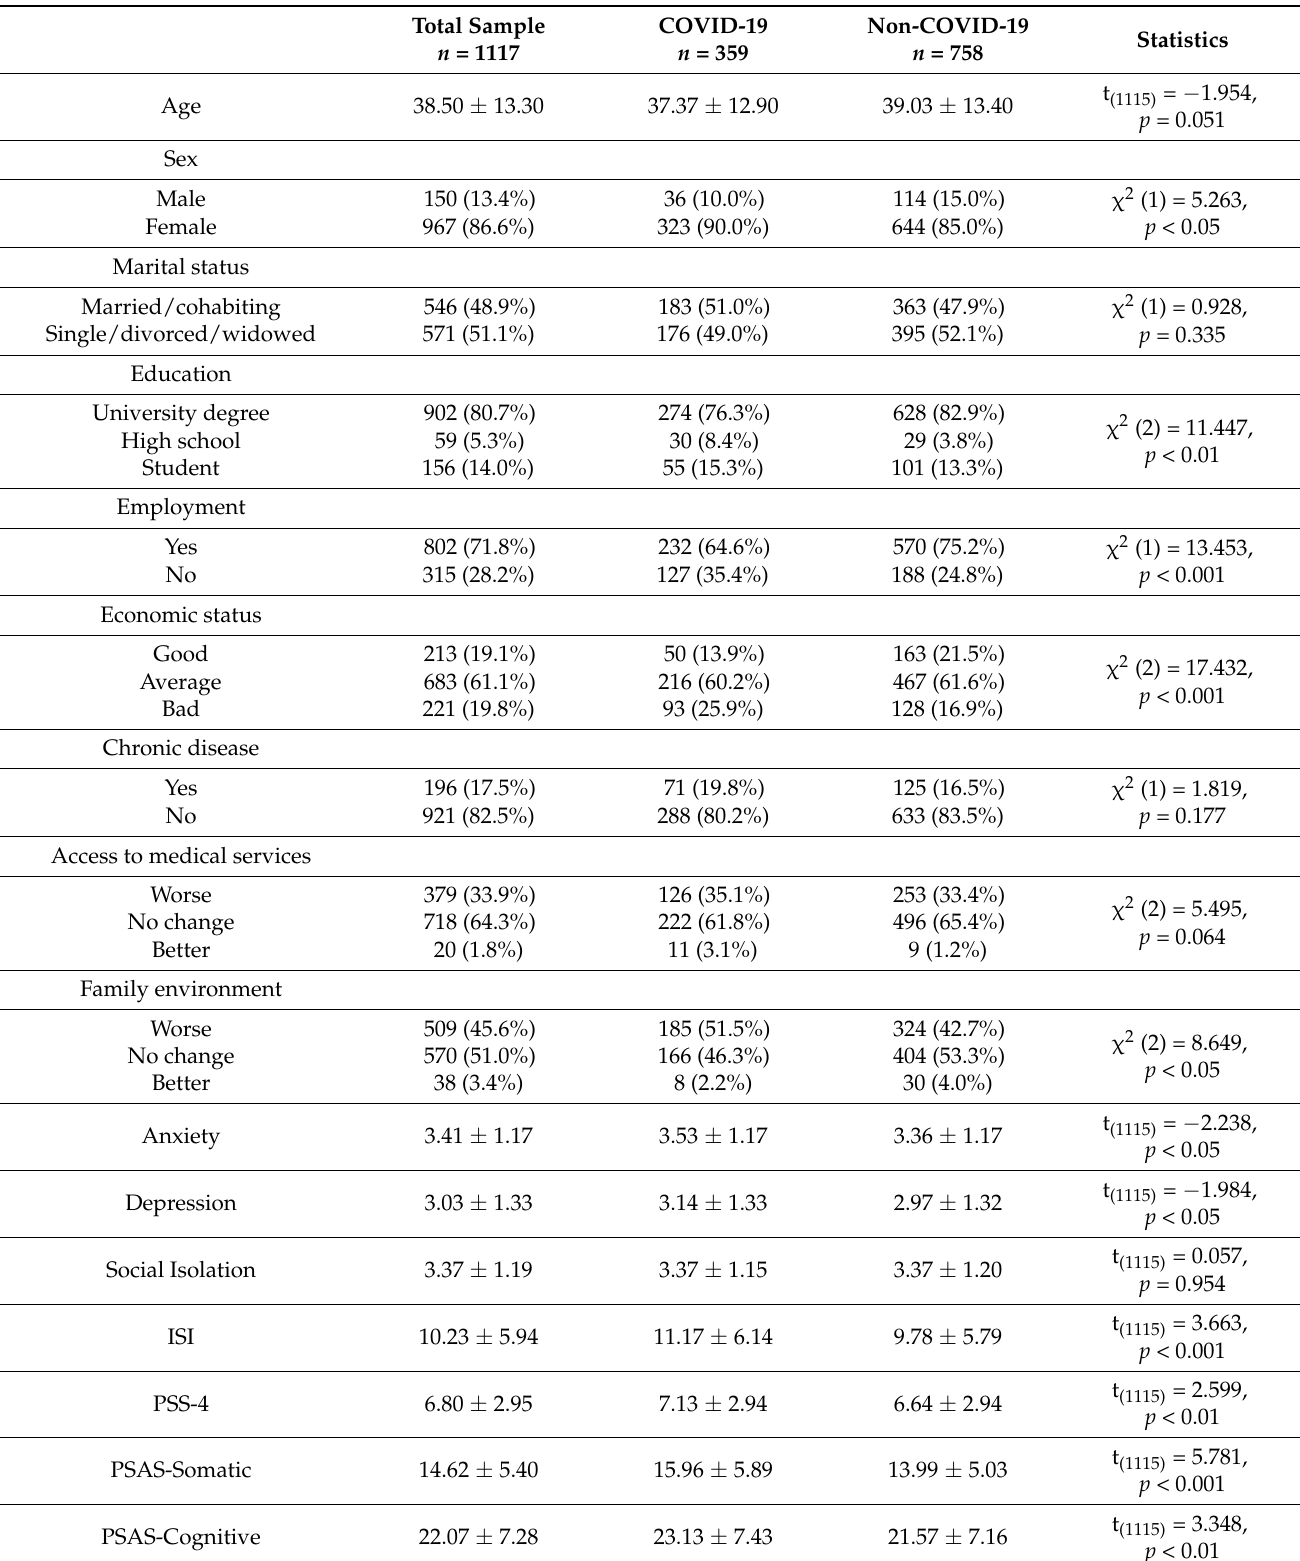
Table 1. Demographic, health and psychosocial variables within the whole sample and separated by the COVID-19